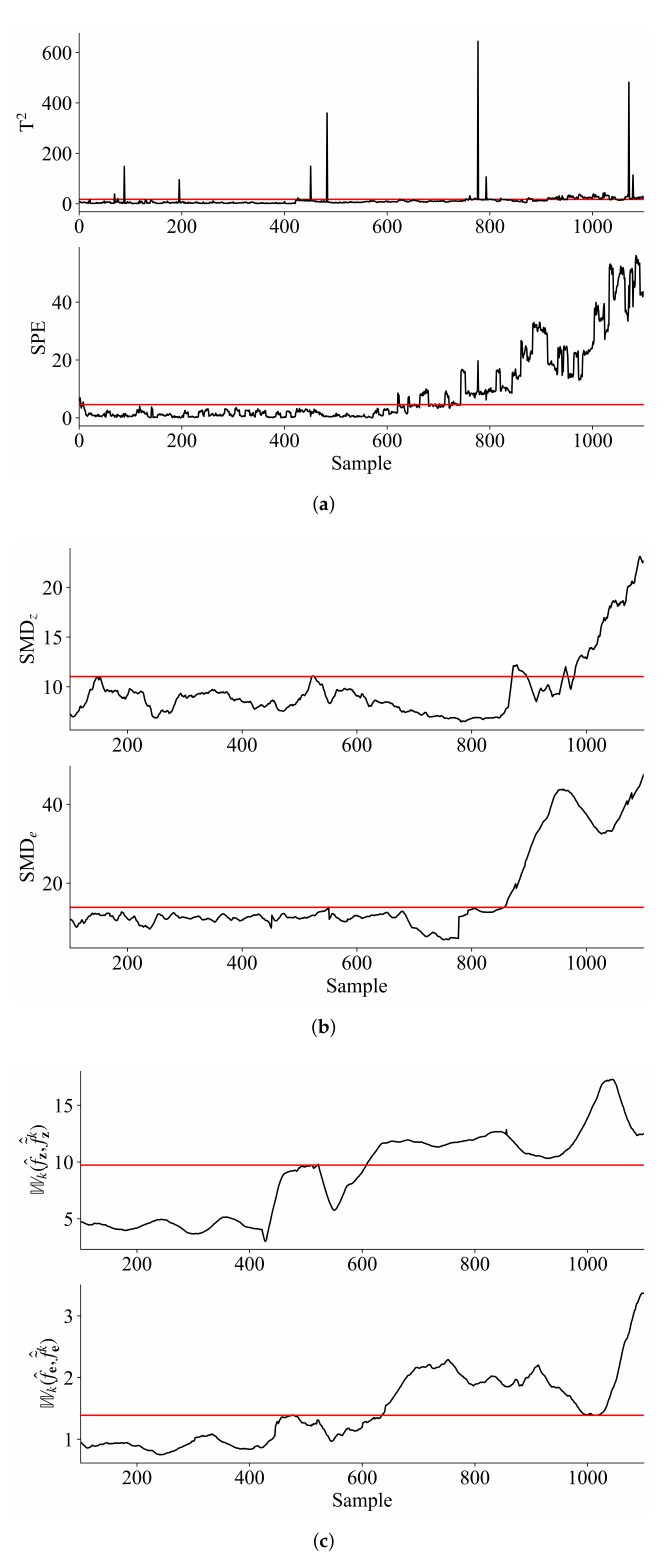
Figure 6. Monitoring results for the boiler water wall over-temperature process: ( a ) PCA ( b ) SMD ( c ) Wasserstein